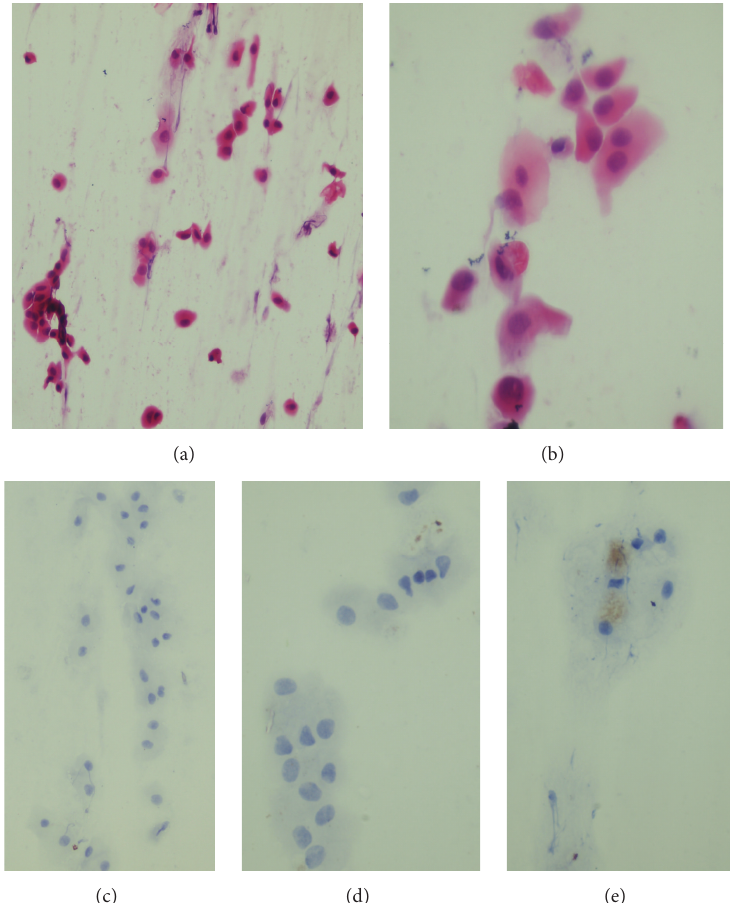
Figure 1: Impression cytology yielded a cellular material of conjunctival columnar cells (a and b). The cells are negative for CK5/6 expression (c and d) apart from weak positive expression in few cells in one case (e). H&E stain (a and b) and CK5/6 immune stains (c, d, and e). Magnification is × 200 (a and c) and × 400 (b, d, and